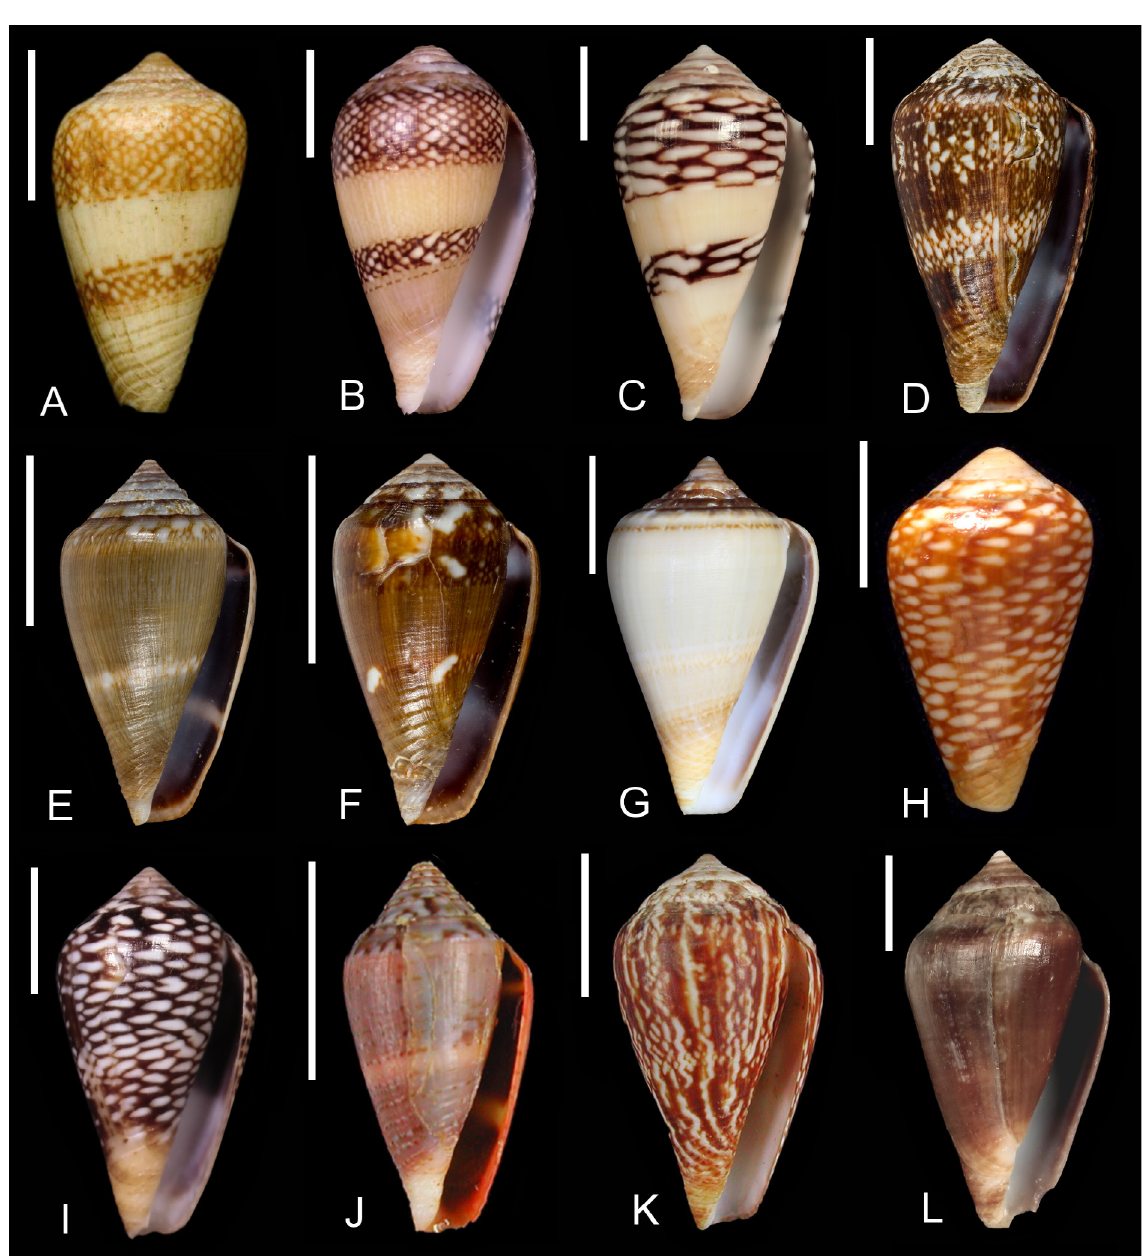
Fig. 11. A . Conus mercator Linnaeus, 1758, lectotype, 24.0 mm (LSL 254). B . Varioconus mercator (Linnaeus, 1758) comb. nov., 34.7 mm (MNCN 15.05/78482). C . Varioconus mercator f. stimpsonorum (Cossignani & Allary, 2019), 39.1 mm (MNCN 15.05/78419). D . Lautoconus fernandi Petuch & Berschauer, 2018, holotype, 35.4 mm (MNHN IM-2000-34012). E . Lautoconus gambiensis Petuch & Berschauer, 2018, holotype, 21.6 mm (MNHN IM-2000-34013). F . Lautoconus rikae Petuch & Berschauer, 2018, holotype, 17.9 mm (MNHN IM-2000-34014). G . Conus orri (Ninomiya & da Motta, 1982), paratype, 30.1 mm (SNMS ZI0091234). H . Conus reticulatus Born, 1778, lectotype, 25 mm (NHMW Mollusca 14159). I . Varioconus reticulatus (Born, 1778) comb. nov., 29.5 mm (MNCN 15.05/78439). J . Conus tacomae Boyer & Pelorce, 2009, holotype, 17 mm (MNHN IM-2000- 21046). K . Conus trencarti Nolf & Verstraeten, 2008, holotype, 26.3 mm (MNHN IM-2000-21455). L . Varioconus unifasciatus (Kiener, 1850) comb. nov., 39.8 mm (MNCN 15.05/78451). Scale bars = 10